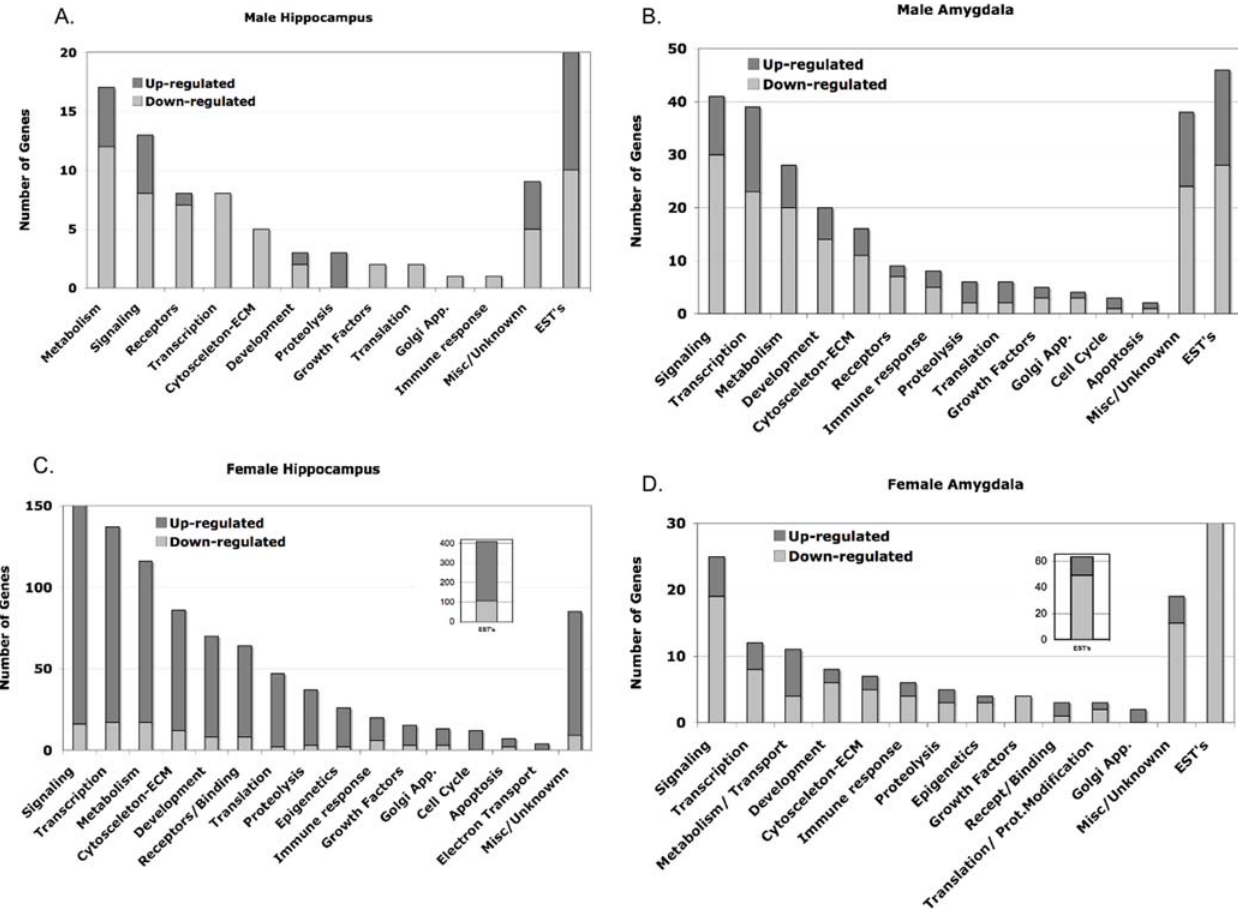
Figure 3. Categorization of genes into functionally related gene groups with the number of genes up-regulated or down-regulated. (A) male hippocampus regulated gene list; (B) male amygdala regulated gene list; (C) female hippocampus regulated gene list; and (D) female amygdala regulated gene list.